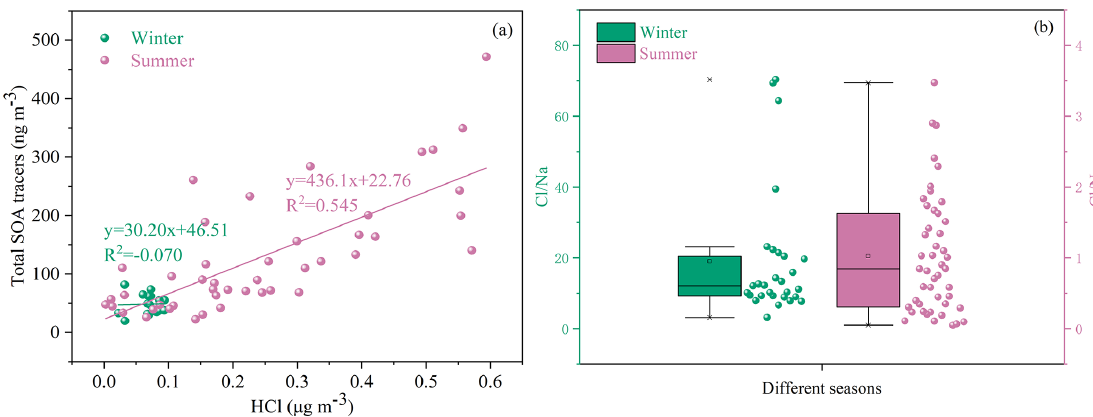
Figure 5. Correlations of total SOA tracers and HCl (a) and chlorine depletion (b) in different seasons.